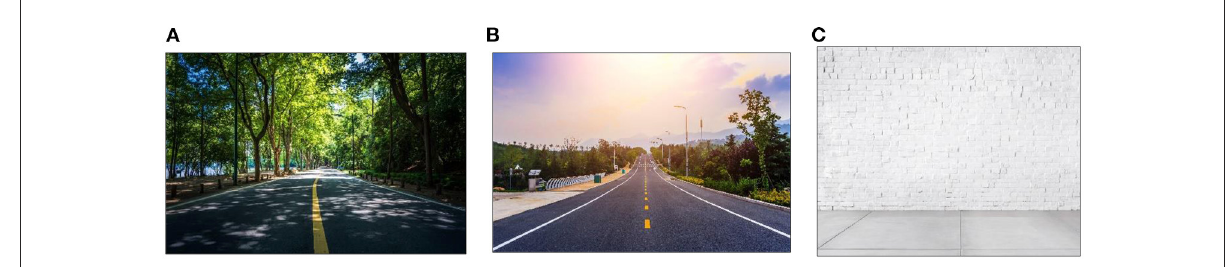
FIGURE1 Experimental images. (A) high tree density sportscape (HTDS); (B) medium tree density sportscape (MTDS); (C) control condition. (Experimental images from evening_tao /